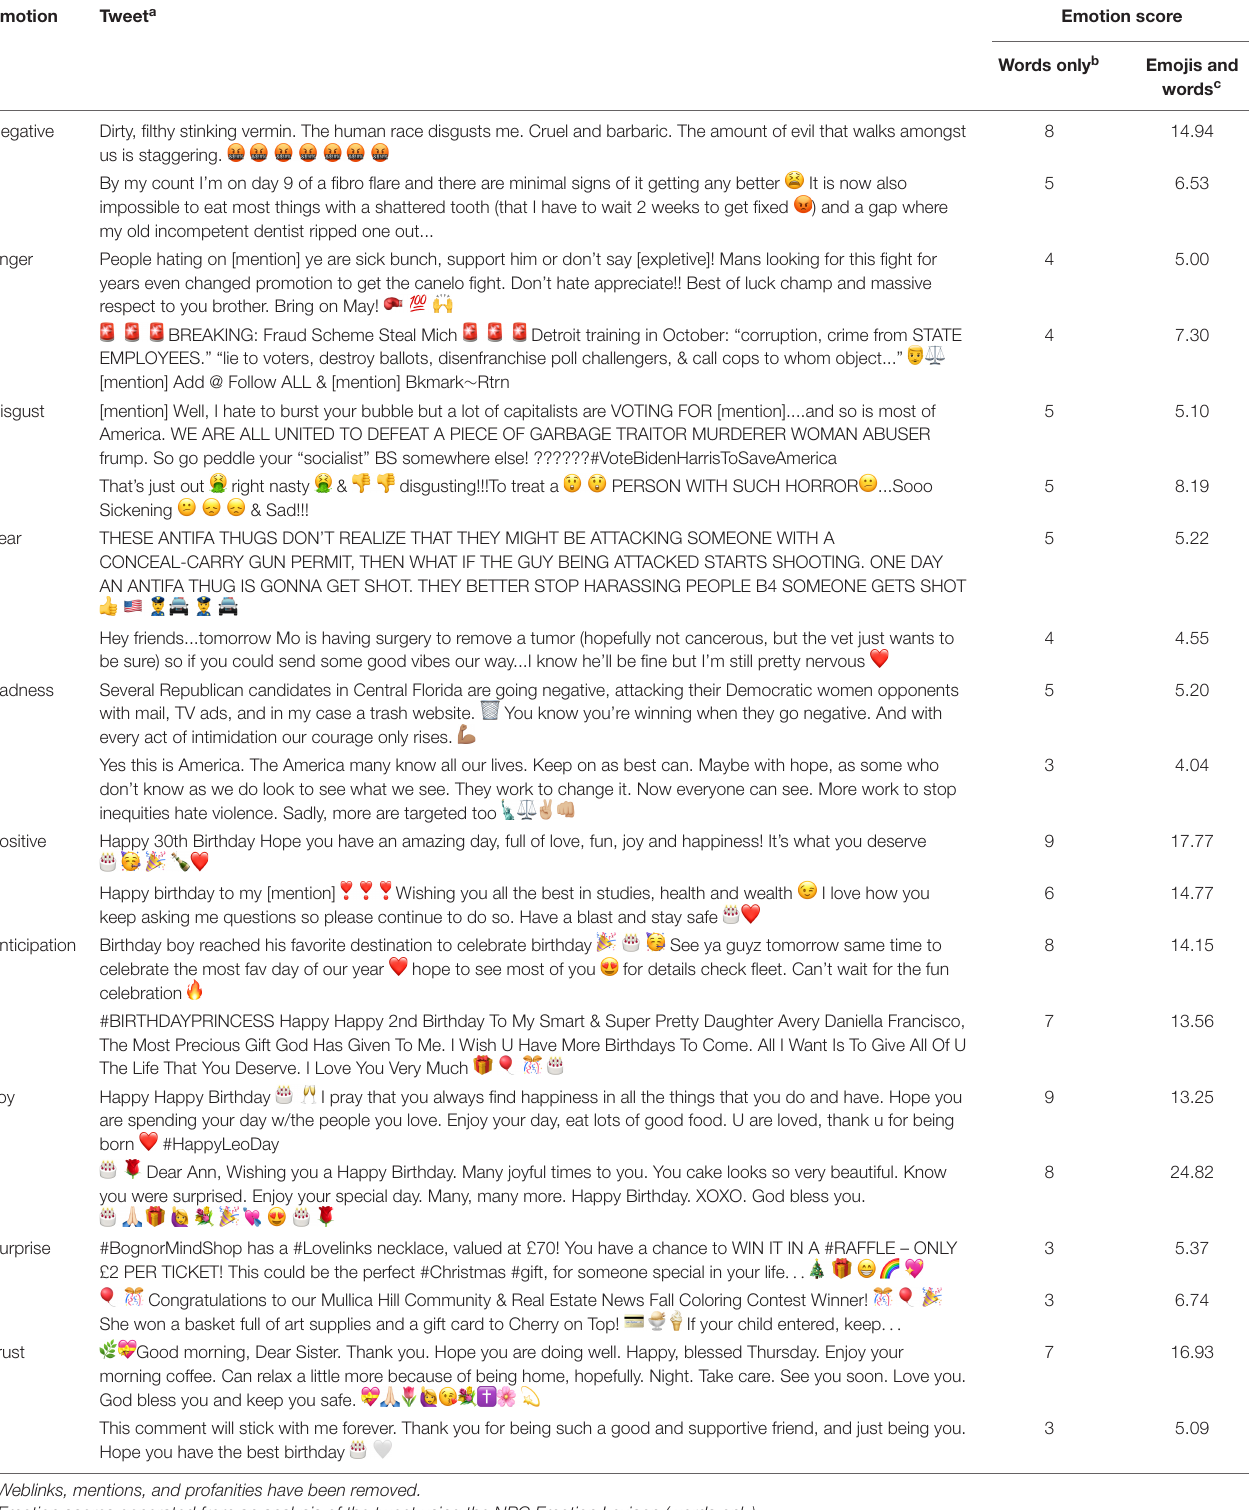
TABLE 2 | Examples of tweets with high emotional content rating using the NRC Emotion Lexicon and the Multidimensional Lexicon of Emojis (MLE). Emotion Tweet a Emotion score